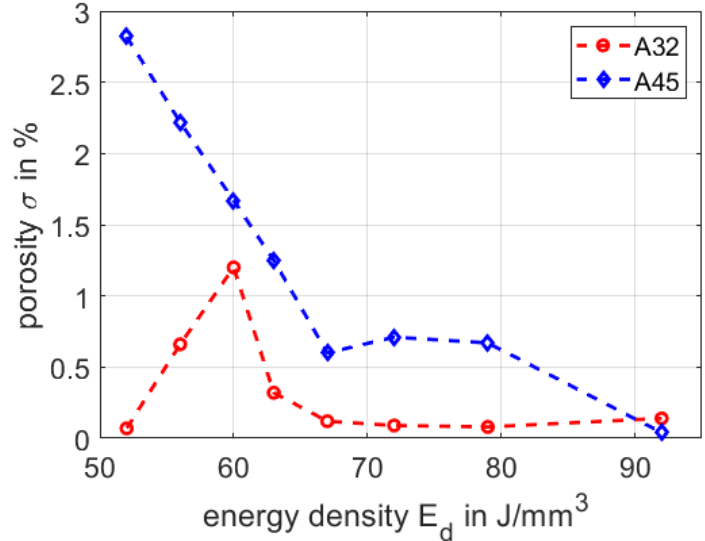
Figure 5. Comparison of the porosity of A32 and A45 in dependency of the energy